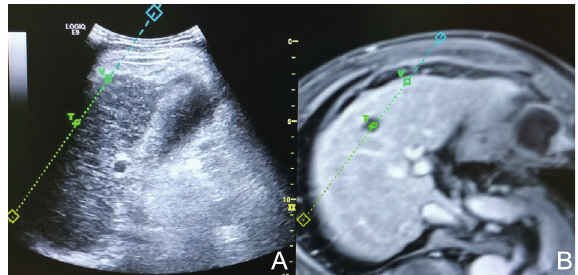
Figure 3 The screen was showing the same plane both ultrasound image (left) and MRI (right) in real time synchronously. “T” represented the lesion which has been marked as the target and the green “□” was marking the needle